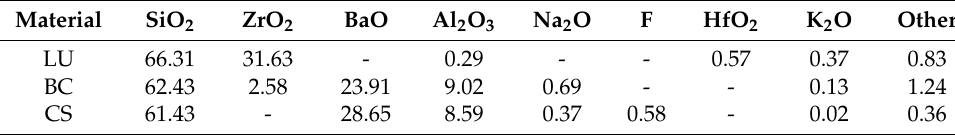
Figure 4. X-Ray fluorescence (XRF) spectrum of LU, BC, CS. Table 2. Element concentration (%) obtained from the XRF analysis.